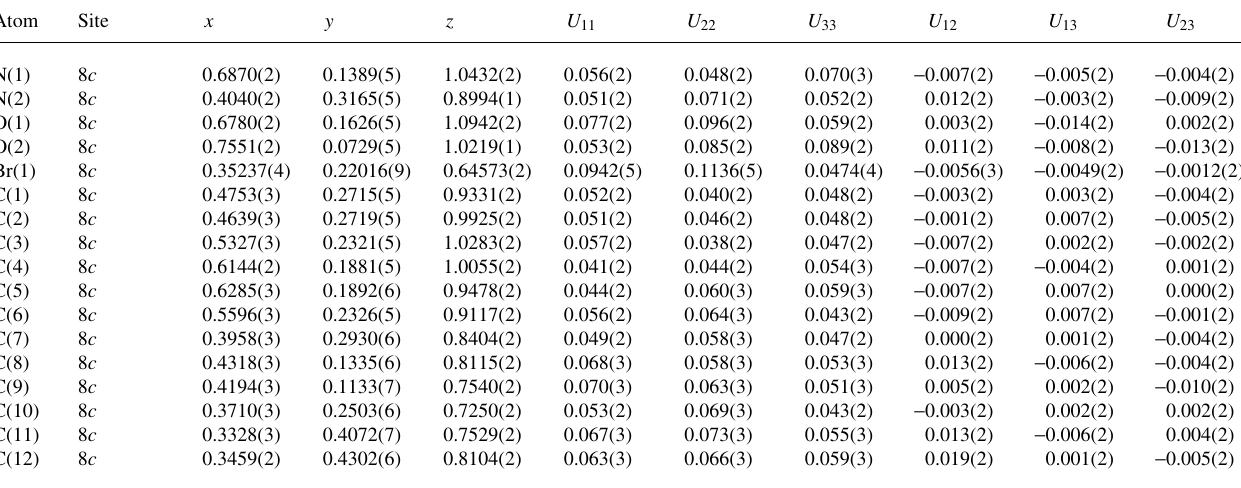
Table 3. Atomic coordinates and displacement parameters (in Å 2 )